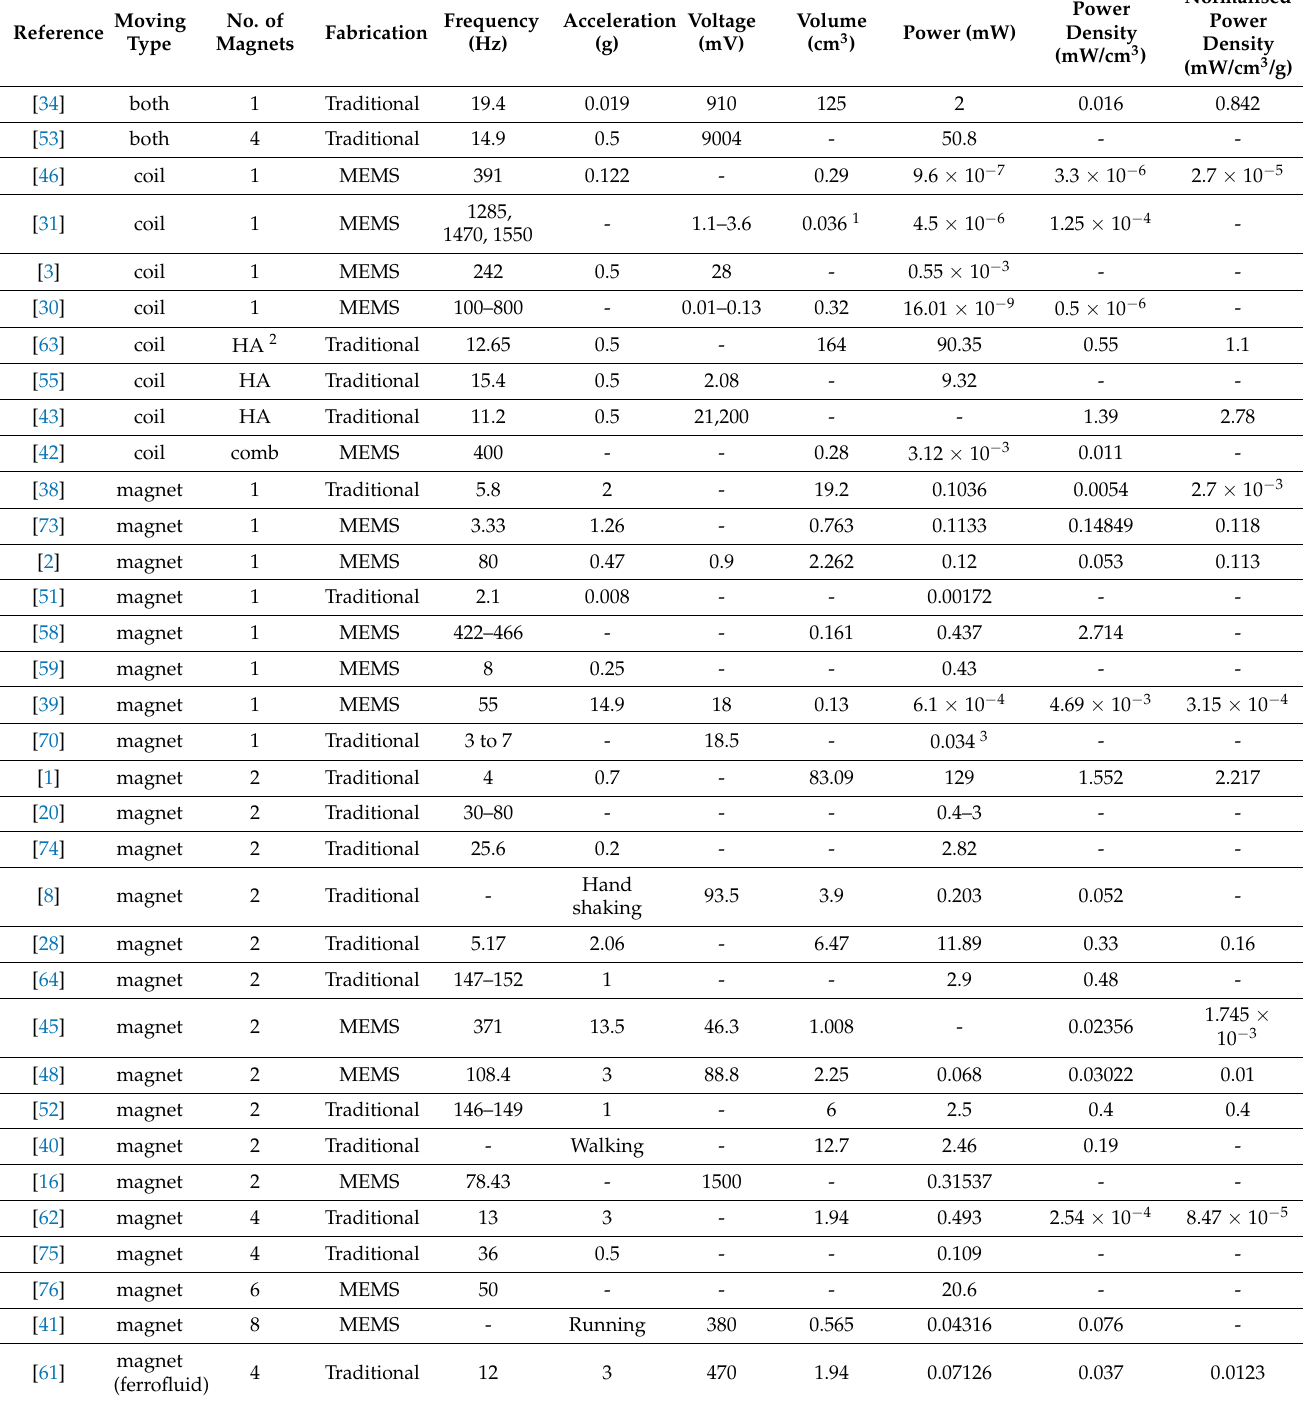
Table 1. Comparison of the characterizations in various designs of electromagnetic